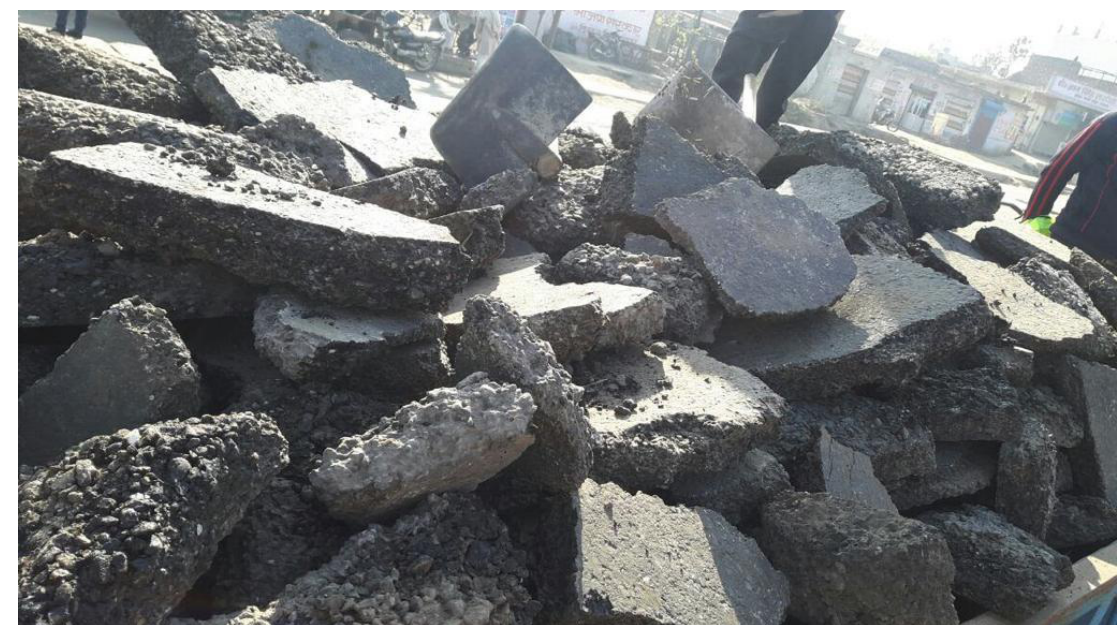
Figure 1. Chunks of RAP stockpiled. Figure 1.